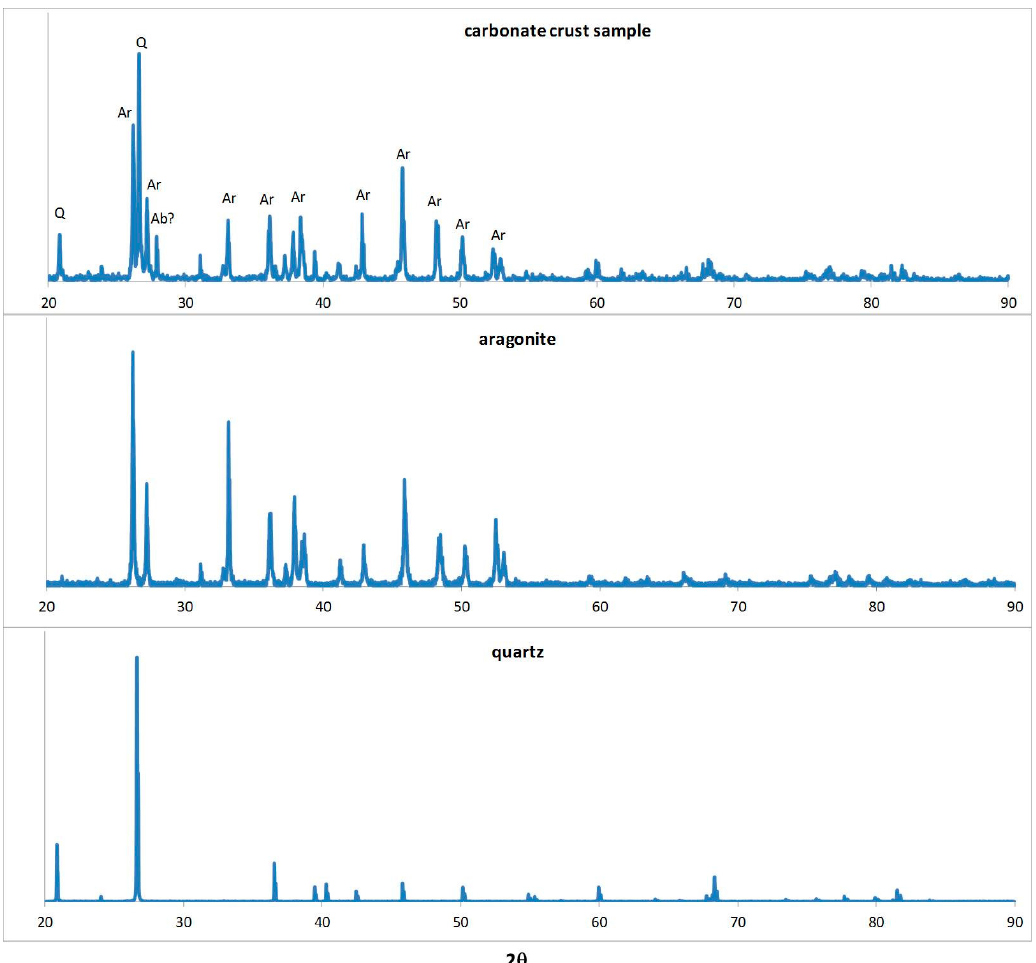
Figure 2. XRD spectra of carbonate crust, aragonite (Ar), and quartz (Q). The presence of albite (Ab) is in question.